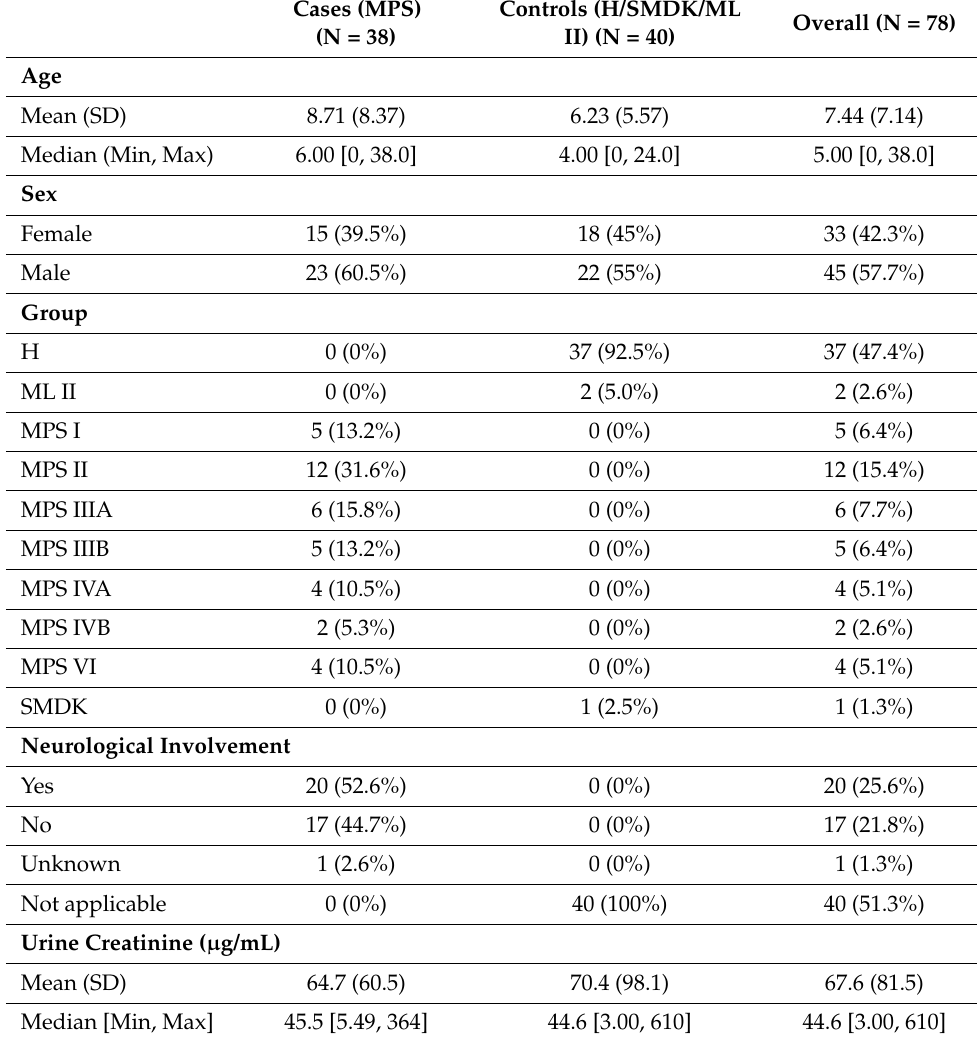
Table 1. Study population baseline characteristics. Keys: H—healthy; MPS—mucopolysaccharidosis; SMDK—spondylometaphyseal dysplasia-Kozlowski type; ML II—mucolipidosis type II; and SD—standard